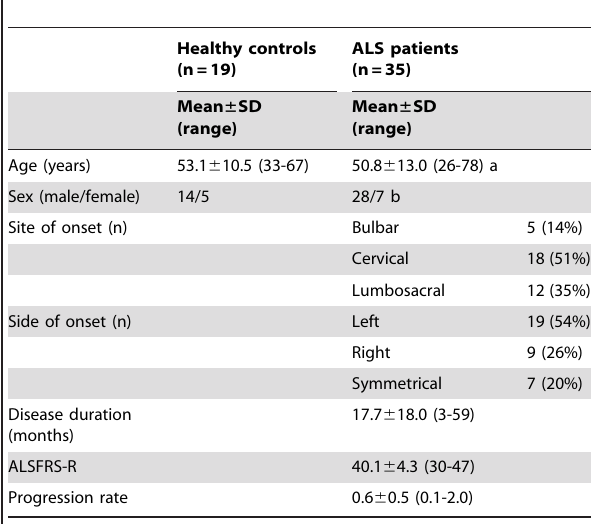
Table 1. Demographic and clinical characteristics of all study